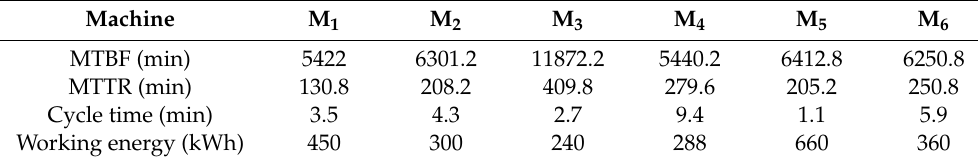
Table 3. Parameters of machines in a serial manufacturing system.